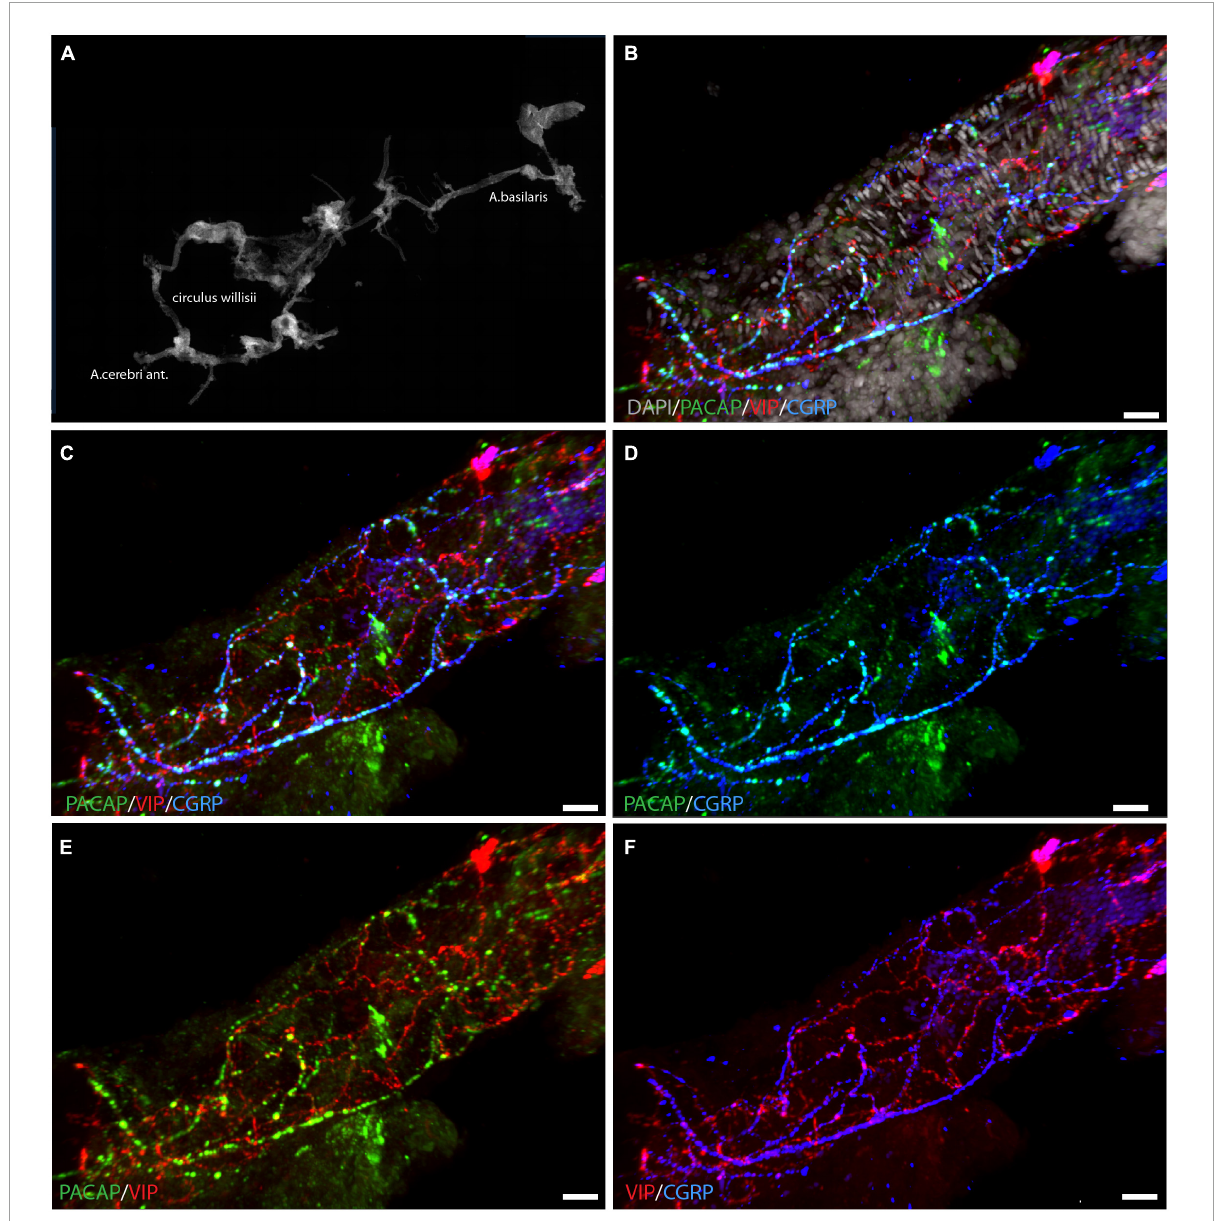
FIGURE1 Localization of PACAP (green), VIP (red), and CGRP (blue) in whole mount preparation of a cerebral artery. An overview of the circle of Willis is seen in panel (A) with DAPI-staining. A segment of a cerebral artery is seen in panels (B–F) with immunostaining of PACAP, VIP, and CGRP in different combinations. Triple immunostaining is shown in panels (B,C) , note that PACAP and CGRP are seen in the same nerve fibers, illustrated in panel (D) . Panels (E,F) visualize the different distribution patterns of PACAP/VIP (E) and CGRP/VIP (F) . Panels (B–F) represent a 3D reconstruction of a Z-stack (Z = 0.5 µ m) of 117 digital sections. Scale bars: (B–F) = 20 µ